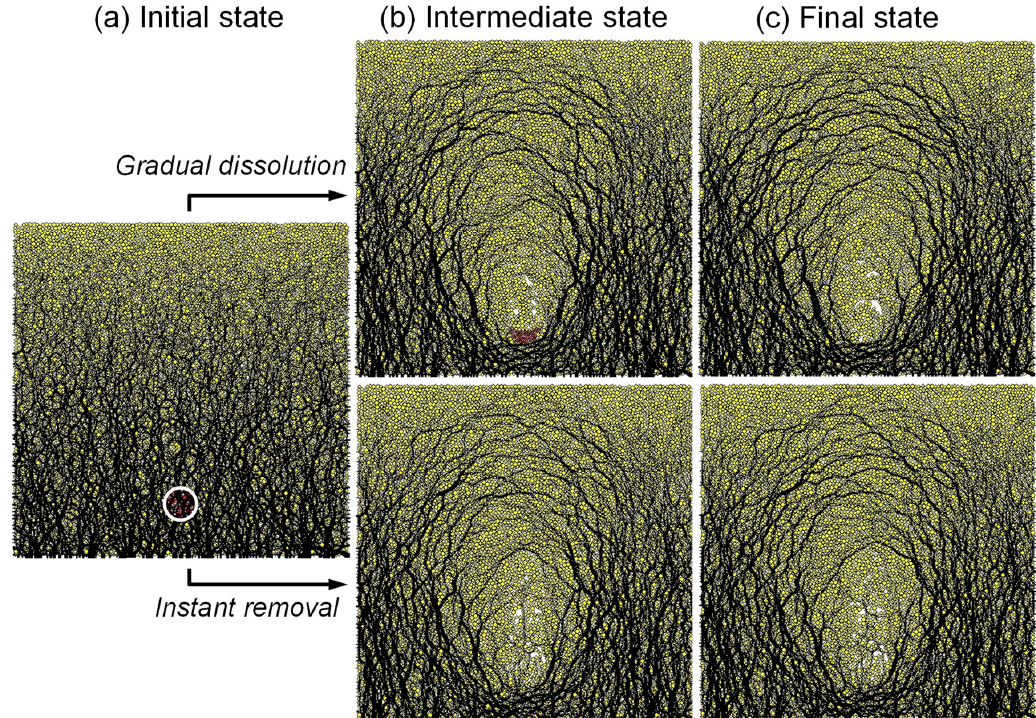
Figure 2. Force chains during subsurface volume contraction: quasi-static gradual dissolution vs. instantaneous removal. The white circle indicates the original location of dissolvable inclusions, and the red particles are soluble. ( a ) Initial force chains. ( b ) Intermediate state during dissolution or after instantaneous removal. ( c ) Final force chains. Note: medium dense packing (e = 0.201), HR = 80%, z/D = 8.5.